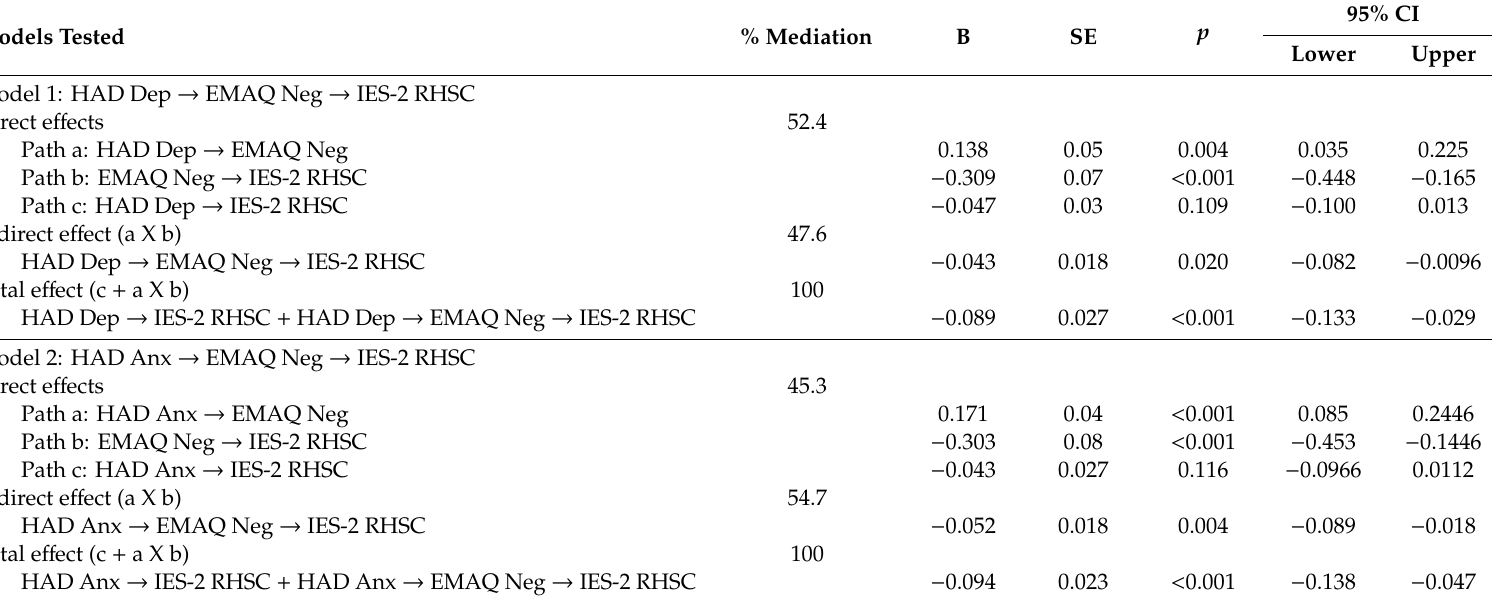
B: Standardized estimate. SE: Standard Error. 95% CI: 95%Confidence Interval. See supplementary Figure S1 for an illustration of Paths a, b, and c as well as the indirect and total e ff